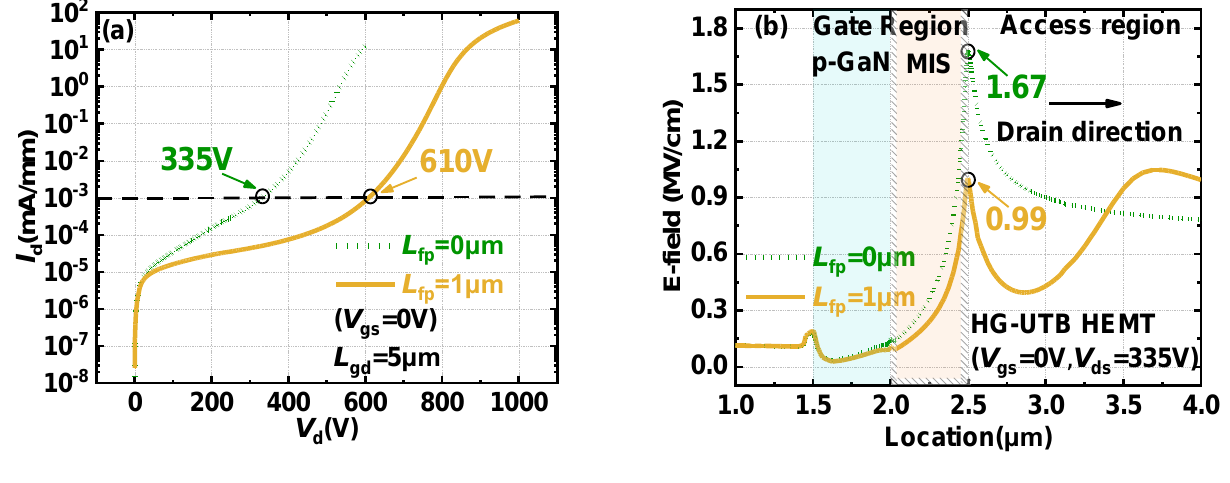
Figure 9. The impact of gate field plate on reverse characteristics of the HG − UTB HEMTs’ ( a ) breakdown performance and ( b ) E − field distribution along the channel.